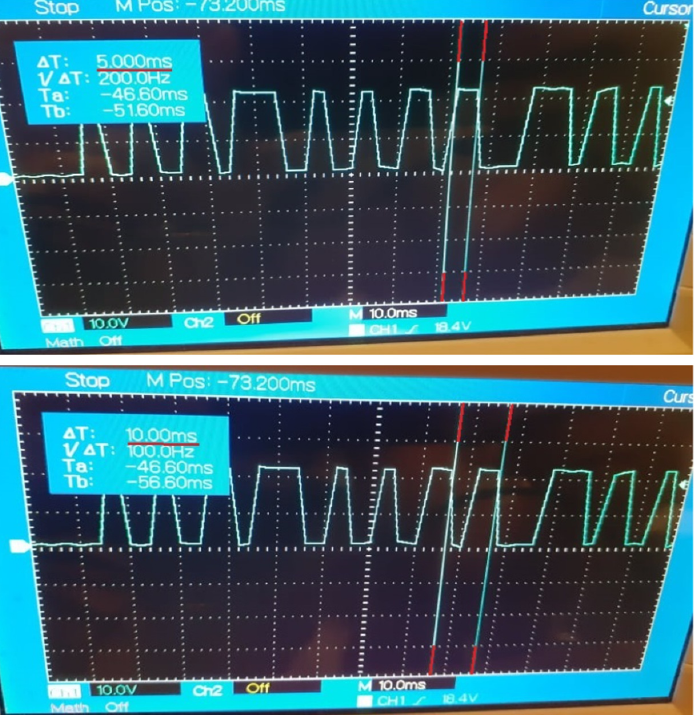
Figure 7. Generated Digital Signal based on payload delivered by the Gateway Application at 5 ms recurrence.